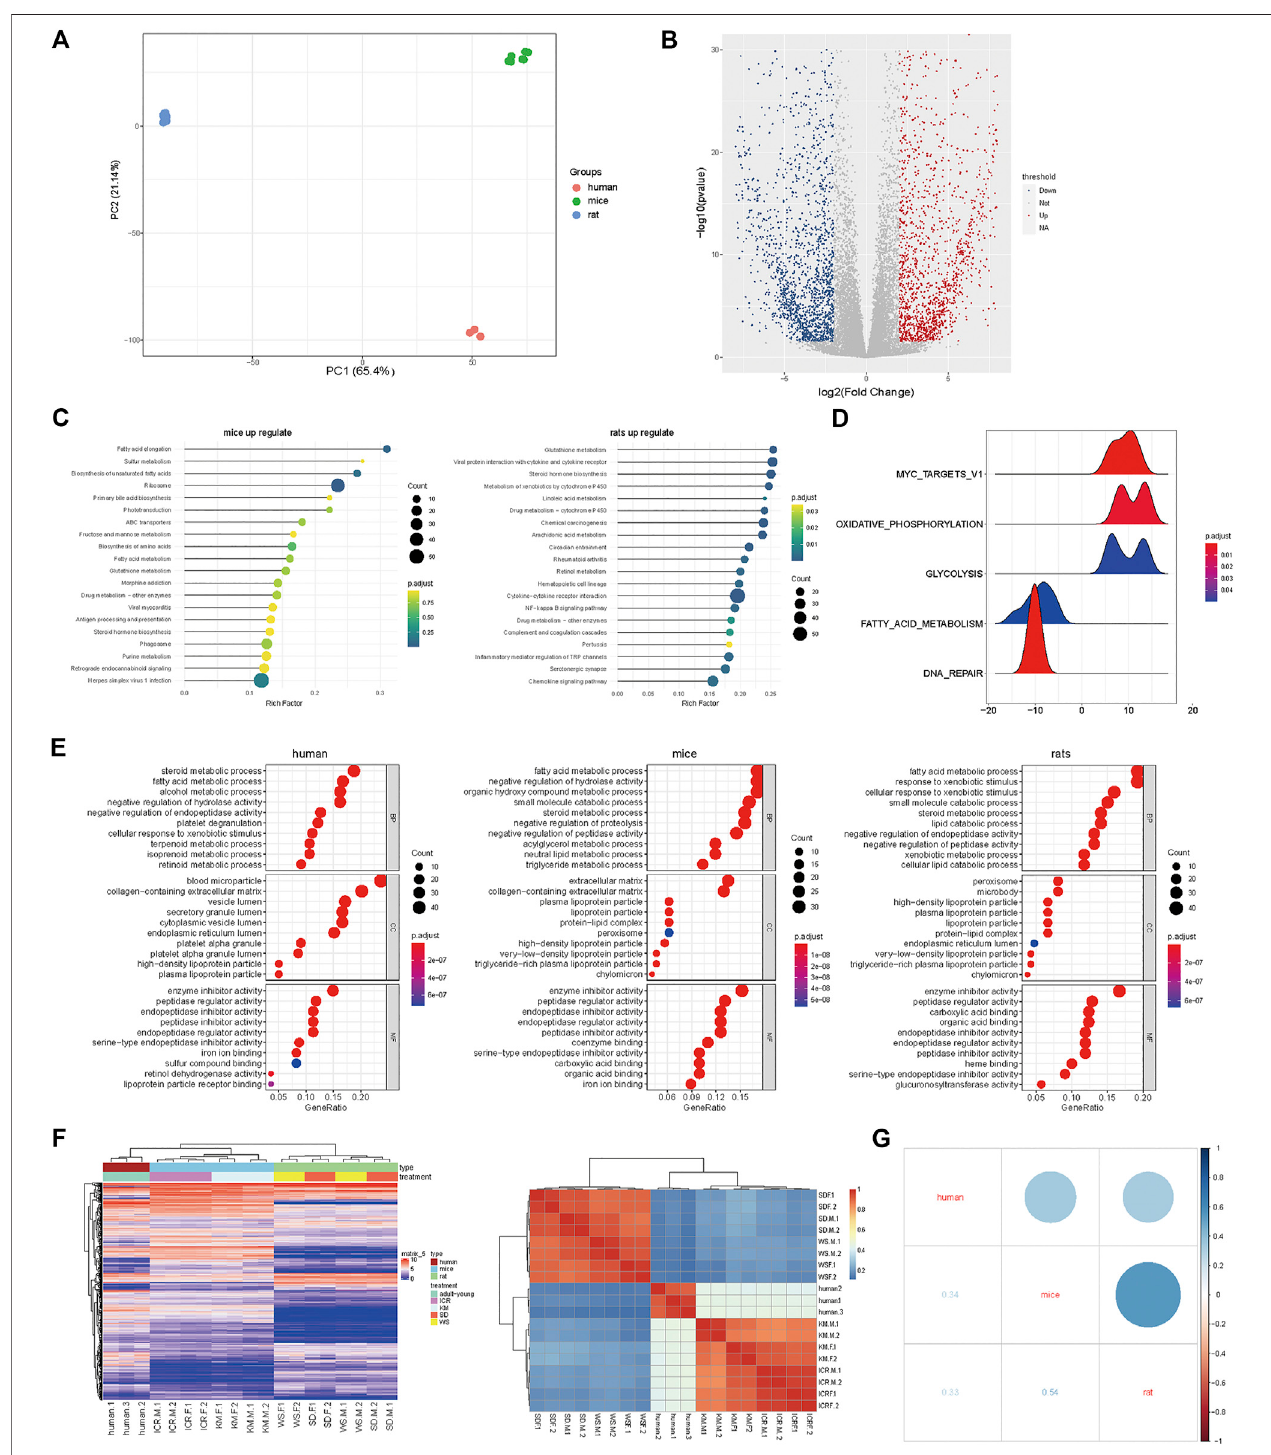
FIGURE3| Mice weremore similartohumansin termsofoxidativestress, and ratsweremore similartohumansin termsoffat metabolism. (A) Heatmapshowing enrichment of oxidative stress in humans, mice, and rats; (B) Expression levels of three species in human oxidative stress gene set; (C) In the concentration of human oxidative stress genes, correlation with ICR mice (left) , and Kunming mice (right) . (D) Heatmap showing enrichment of steatosis in humans, rats, and mice; (E) Expression levels of three species using the human steatosis gene set (left) ; (F) In the concentration of human steatosis genes, correlation with Sprague-Dawley Rats (left) and Wistar rats (right)